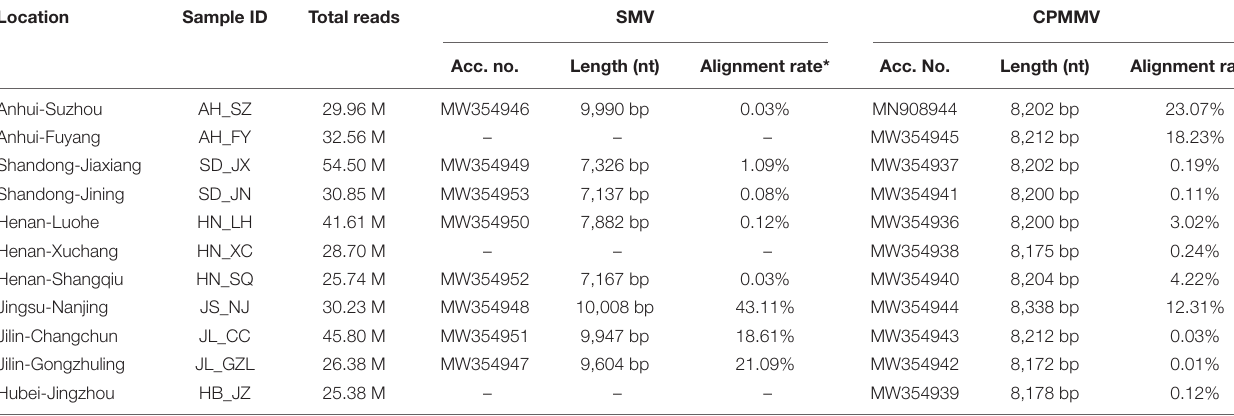
TABLE 1 | Summary of Illumina sequencing and assembling